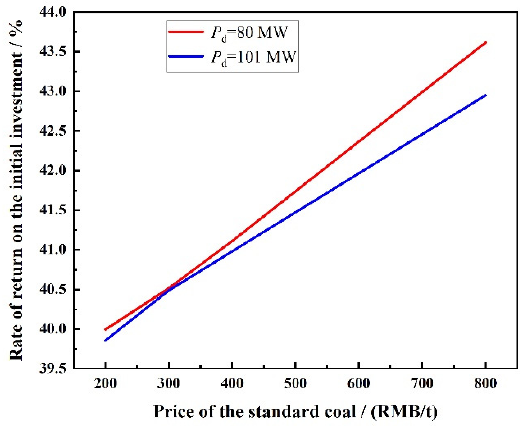
Figure 12. Annual after-tax profits vs. the price of the standard coal.